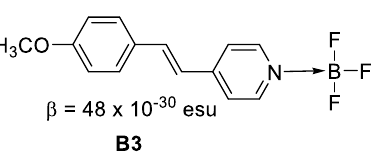
Figure 6. Boron in neutral form.